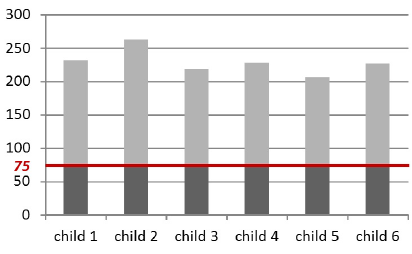
Fig. 3. SRS row score in each participant